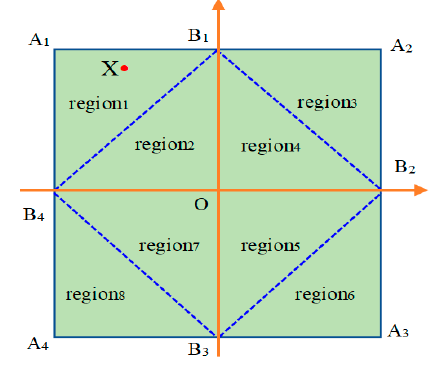
Figure 4. A schematic of the positioning model.